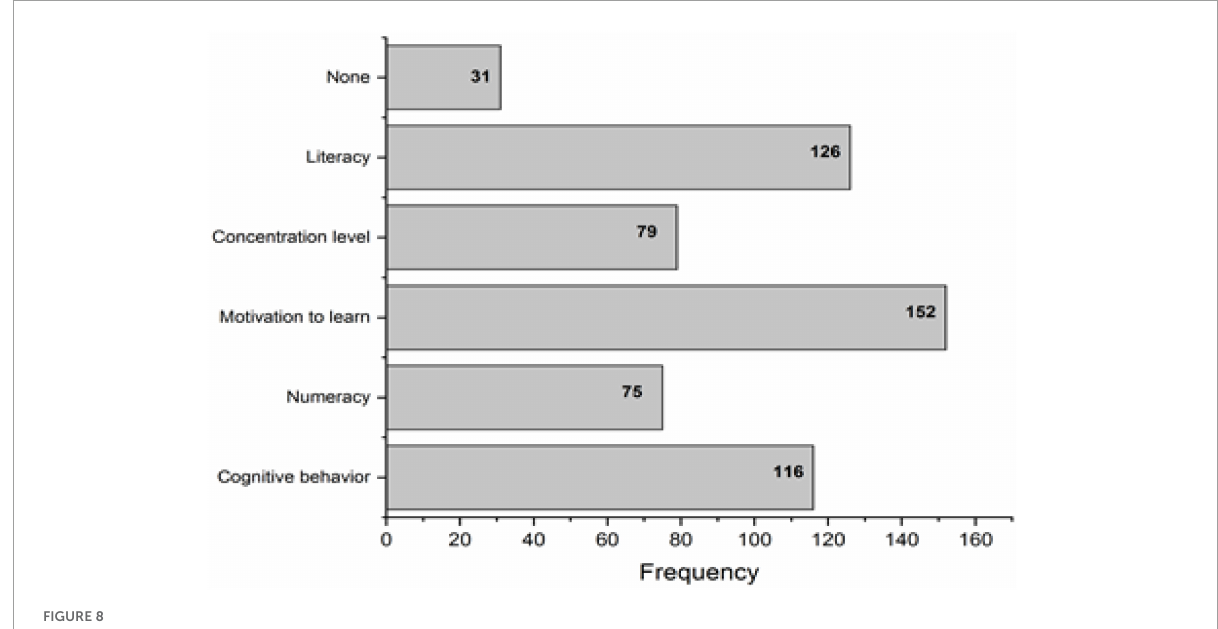
FIGURE8 What were the negative impacts of the school closures on students?